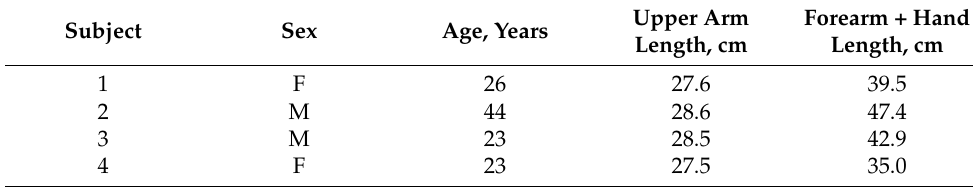
Table 2. Characteristics of healthy